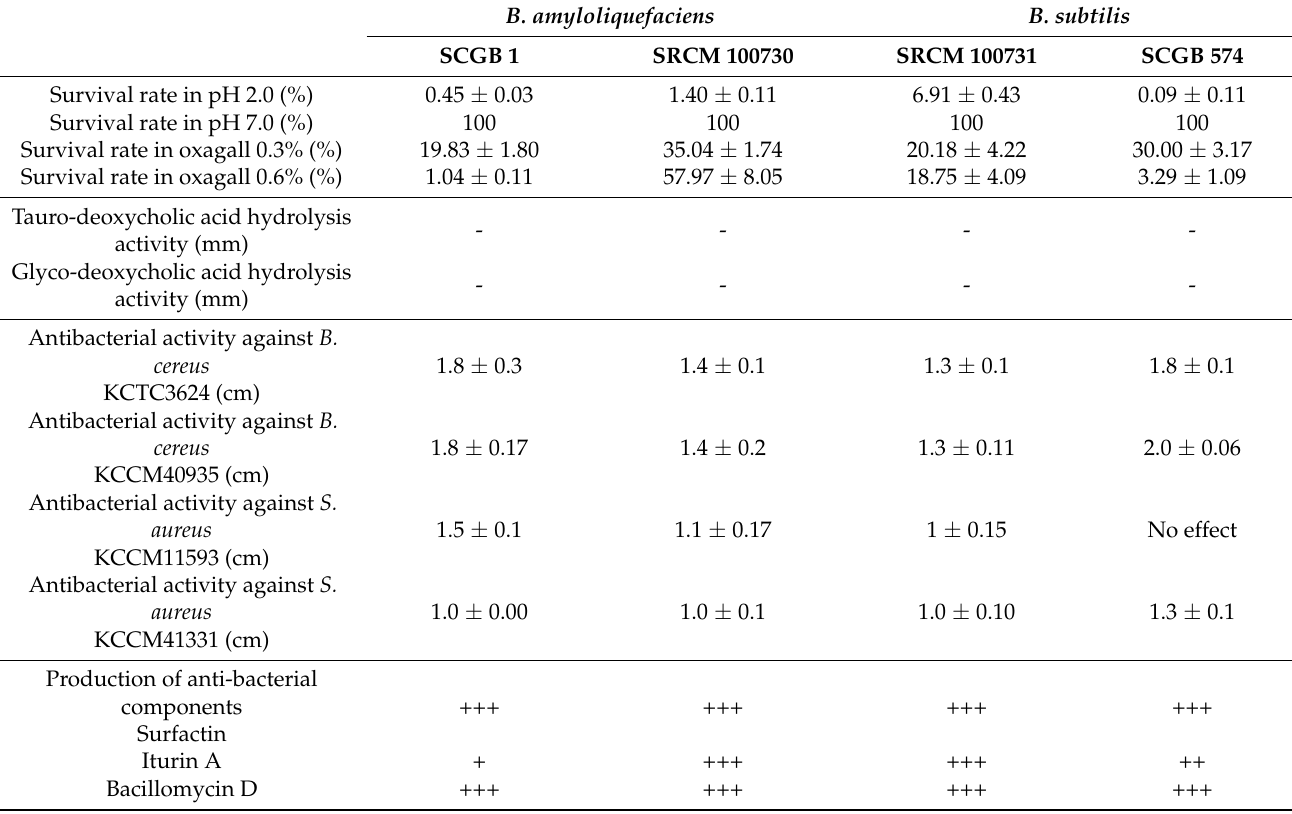
Table 2. Characteristics of Bacillus species isolated from traditionally made chungkookjang. B.